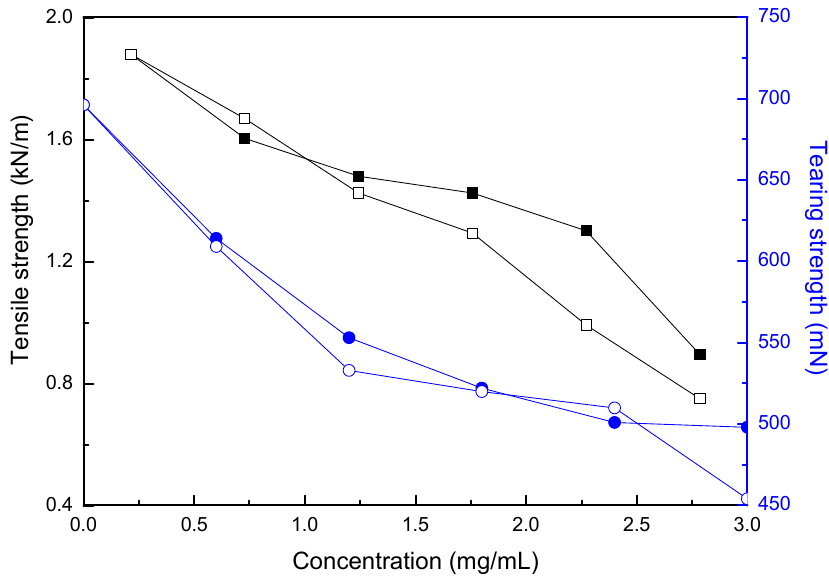
Figure 6. Influence of microcapsule concentration on the tensile and tearing strength of paper (blue: tensile strength; black: tearing strength; solid: drug loaded samples; hollow: drug unloaded samples).